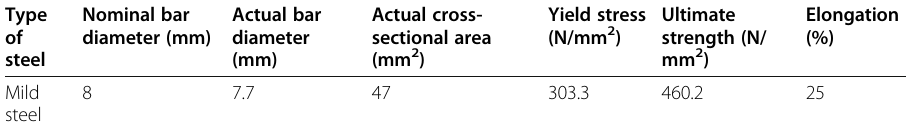
Table 7 Geometric and mechanical properties of the used high deformed and mild steel bars complying with ESS 262/2009 Type